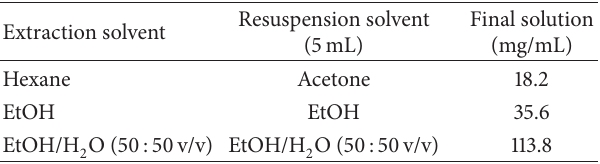
Table 2: B. orellana seed extracts for mosquito repellency evalua-